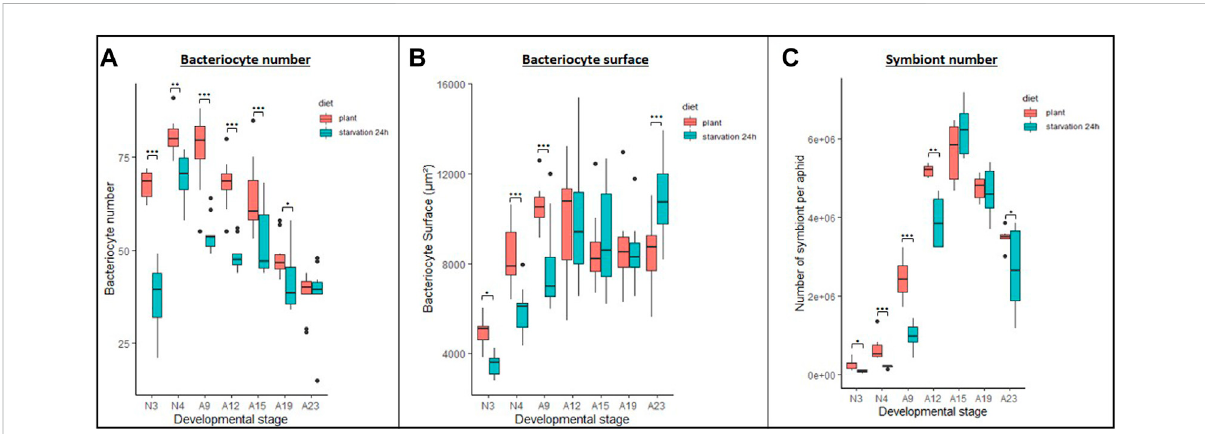
FIGURE 5 Impact of starvation stress on bacteriocyte and symbiont dynamics. (A,B) Variation in the number (A) and average surface (B) of bacteriocytes per aphid reared on plant from their birth (plant, red) or that were transferred back to plant after a 24 h starvation period (starvation 24 h, cyan), in relation to host developmental stage. Results are displayed as box plots where central lines represent the medians, boxes comprise the 25 – 75 percentiles and whiskers denote the range; n = 10 aphids per stage and per condition, for a total number of 140 aphids dissected and analyzed. Data on bacteriocyte numbers were analyzed with a generalized linear model followed by post hoc multiple comparisons tests. Data on bacteriocyte surfaces were analyzed with a mixed-effects model considering individual aphids as random factors followed by post hoc multiple comparisons tests. Signi fi cant differences are indicated with asterisks (*, p < 0.05; ***, p < 0.001). (C) Variation in the numbers of symbionts in A. pisum from the control (plant, red) or starved (starvation 24 h, cyan) population, in relation to host developmental stage. Symbionts were quanti fi ed by fl ow cytometry analysis of whole insects. Results are displayed as box plots where central lines represent the medians, boxes comprise the 25 – 75 percentiles and whiskers denote the range; n = 6 independent biological replicates per stage and condition (each biological replicate